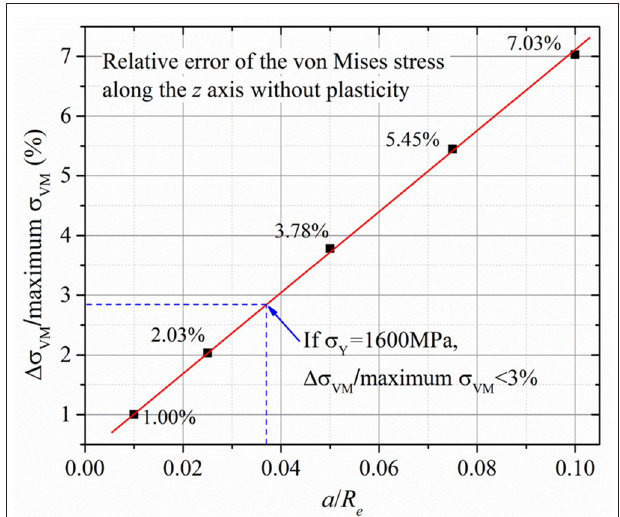
FIGURE 1 | Maximum errors of the von Mises stress, σ VM , along the z axis, or the central axis in the depth direction, by using the half-space approach to solve the problem of contact of two equal spheres, without considering plasticity, calculated with the FEM; a is the half contact width, R e is the equivalent radii of the contact bodies, and 1 / R e